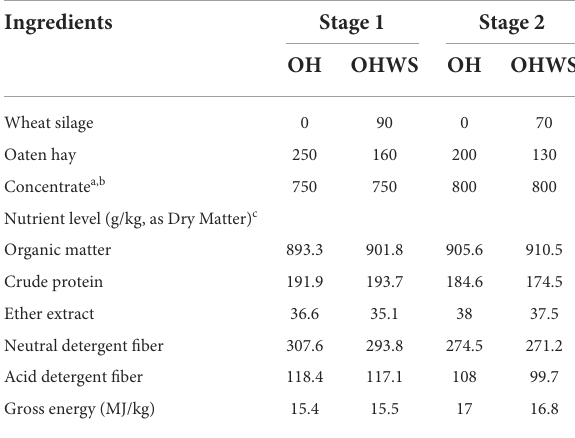
TABLE 2 Ingredient and chemical composition of total mixed rations with different forage type fed to lambs at different feeding stages (stage 1, 1–62 day; stage 2, 63–120